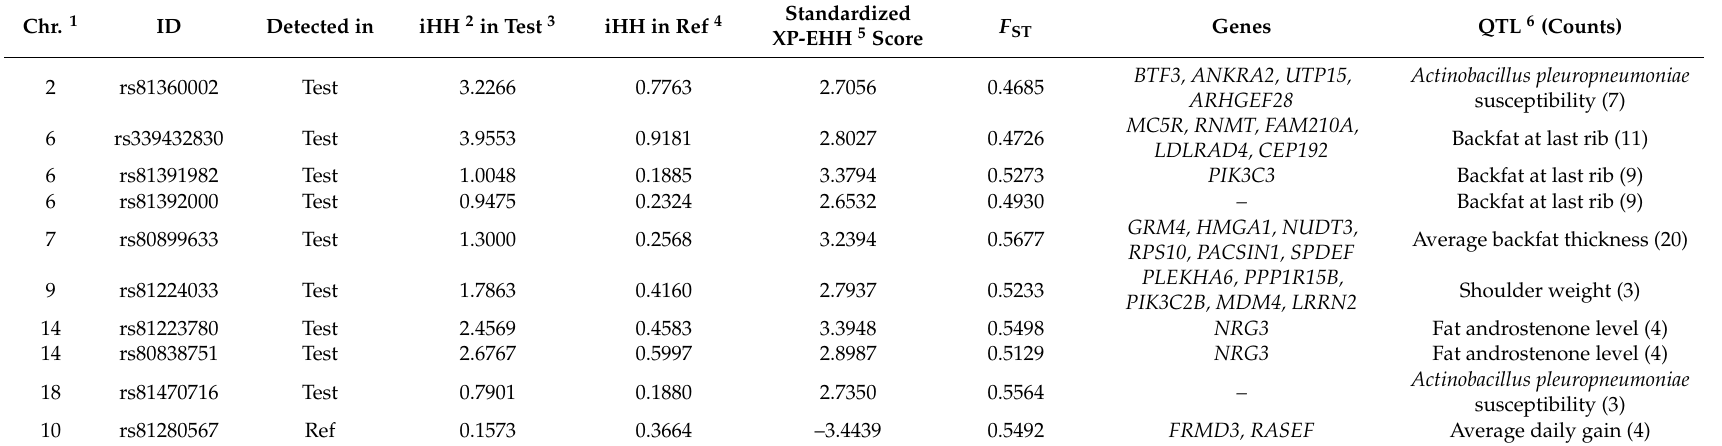
Table 1. Summary of significant single-nucleotide polymorphisms (SNPs) detected simultaneously by two methods in the Ding’an and Tunchang / Baoshan pig groups. Chr.